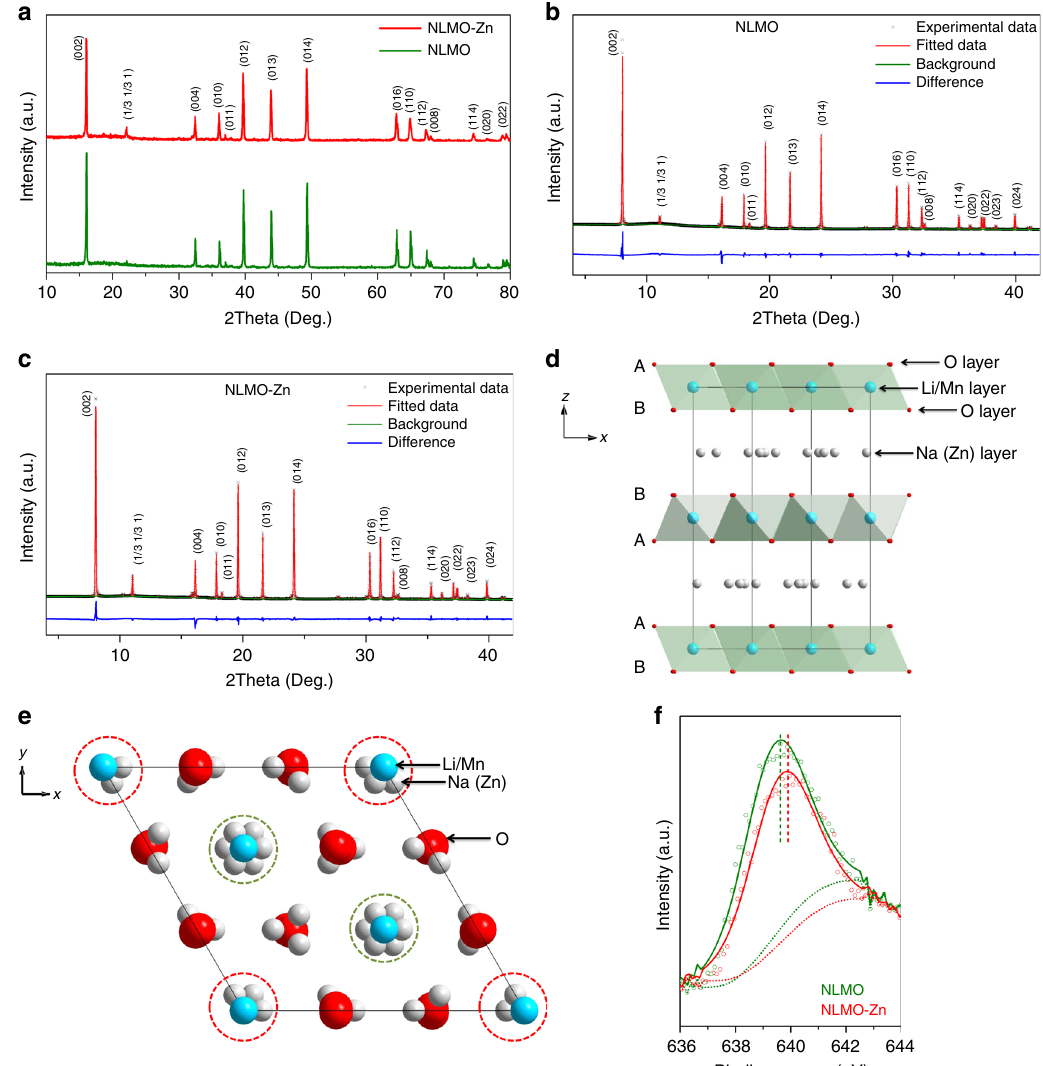
Fig. 3 Structural analyses of NLMO and NLMO-Zn. a Shows the XRD patterns of NLMO and NLMO-Zn. b , c Show the Rietveld re fi nement results for high- resolution diffraction patterns (HRPD) of NLMO and NLMO-Zn, respectively. Crystal structure of P2-type NLMO (or NLMO-Zn) viewed along the y -axis ( d ) and the z -axis ( e ). f Shows the XPS spectra in the Mn 2 p 3/2 region of NLMO and NLMO-Zn